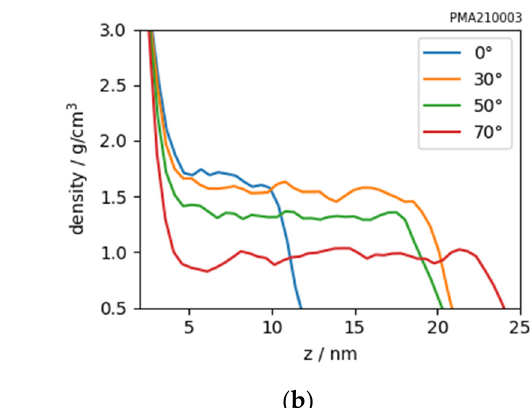
Figure 3. Density profiles in growth direction z of TiO 2 for an incidence angle of 0° and a substrate area of 7 × 8 nm 2 . The comparison between using different interaction potentials is shown. For the Matsui potential [9] the standard deviation shown as shaded region is computed from four independent simulations. With the Zhang potential [10] a lower density is obtained.